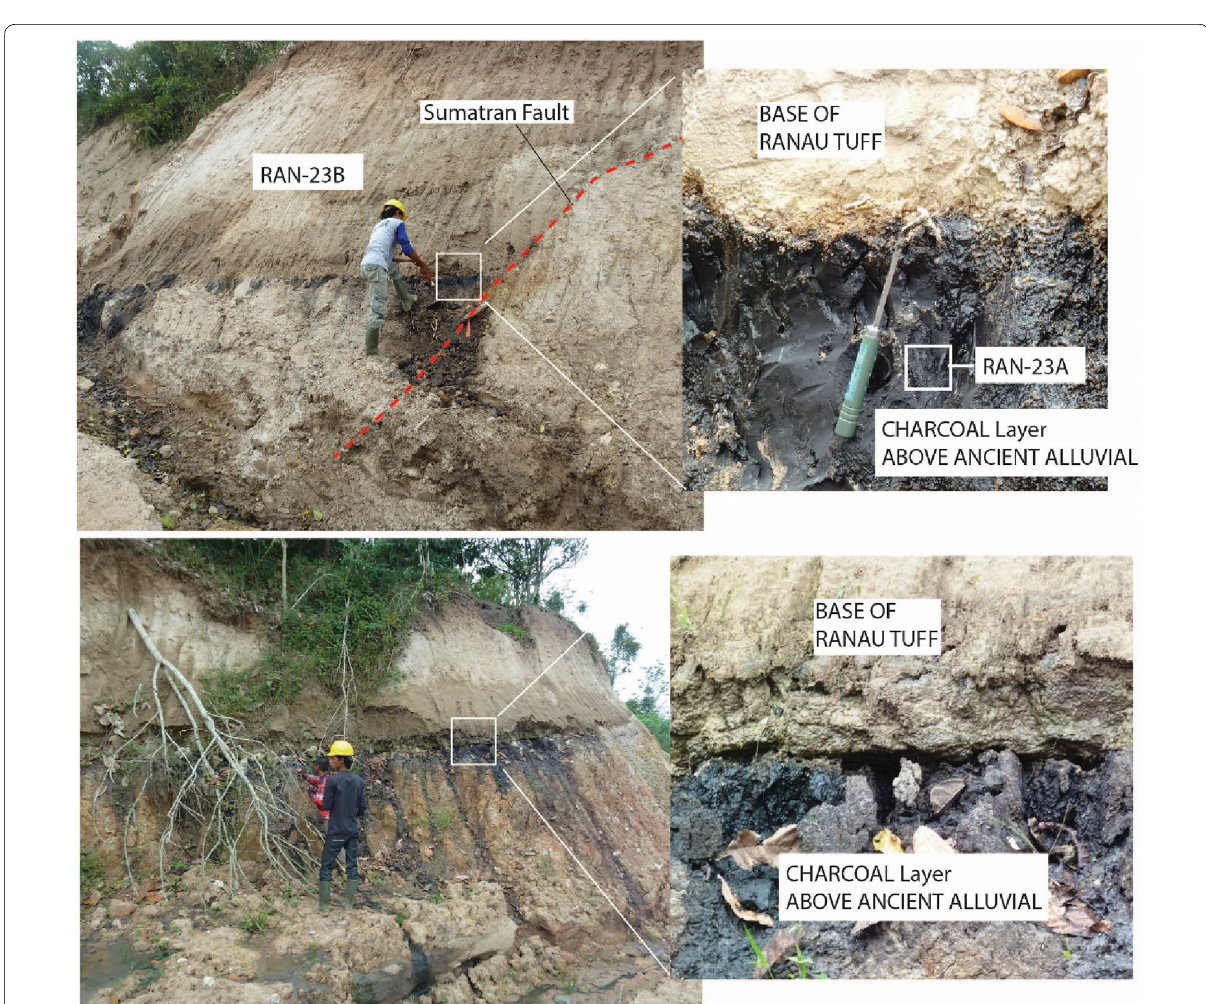
Fig. 6 Two outcrops of the distal Ranau Tuff in the Semangko Valley 50 km from the eruptive center, showing several meters of fine-grained tuff overlying a layer of charcoal on top of alluvial sediments. a At site 1